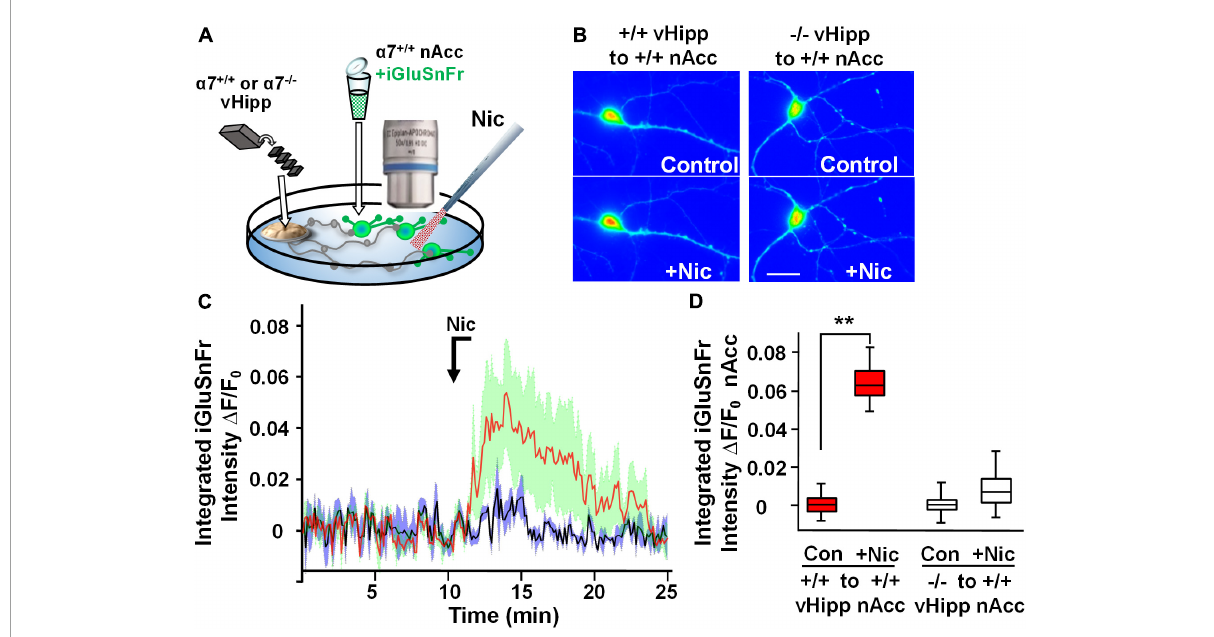
FIGURE4 Hippocampal axonal α 7* nAChRs are required for nicotine-evoked glutamate release at sites of ventral hippocampal – nucleus accumbens interaction. Nicotinic modulation of glutamatergic signaling was examined in gene chimeric co-cultures of ventral hippocampus (vHipp – plated as thinned microexplants) and nucleus accumbens neurons (nAcc – plated as dispersed neurons). (A) Schematic diagram of experimental configuration. Neurons, dispersed from P1, α 7+/+ mouse nAcc were plated in media containing iGluSnFr (AAV 9 .hSyn. iGluSnFr.WPRE .SV40) for 24 h prior to washout and addition of vHipp microexplants. Individual WT ( α 7+/+) or α 7 knock out ( α 7–/–) mice were used for each plating of vHipp micro-explants [prepared as previously described (Zhong et al., 2008)]. After plating of the microexplants, additional incubation in reduced media volume was allowed for explant thinning. After 7–10 days of co-culture, iGluSnFr fluorescence activity in the dispersed nAcc neurons was used as a read out of glutamate release. (B) Representative spinning disk confocal images of iGluSnFr fluorescence in nAccs neurons recorded from α 7+/+ or α 7–/– vHipp to α 7+/+ nAcc co-cultures before (top) and after (bottom) nicotine (1 µ M, 1 min) application. The relative signal intensity in the nAcc neurons, indicated by a pseudo color scale, is equivalent to significant increases in nicotine induced- glutamate release in co-cultures where vHipp is from α 7+/+ mice (orange/red). In contrast, nicotine had little effect on glutamate release in co-cultures with α 7–/– vHipp: Scale bar: 10 µ m. (C) Averaged traces of nicotine induced changes in normalized somatic iGluSnFr intensity as a function of time. The red line shows the averaged somatic iGluSnFr intensity time course ( ± SD in green shading), from six examples of nAcc neurons from α 7+/+ mice, cocultured with α 7+/+ vHipp explants, before and after nicotine (1 µ M, 1 min) application. The black line shows the averaged somatic iGluSnFr intensity time course ± SD in gray shading from five examples of nAcc neurons from α 7+/+ mice co-cultured with α 7–/– vHipp explants before and after nicotine application. Note that the nicotine induced glutamate release recorded in the +/+ vHipp to +/+ nAcc co-cultures was not seen in –/– vHipp to +/+ nAcc co-cultures. (D) Box plots of pooled data: Nicotine increased integrated iGluSnFr intensity ( (cid:49) F/F 0 ) in co-cultured nAcc neurons with α 7+/+ vHipp innervation (** p < 0.01, eight neurons/condition three separate